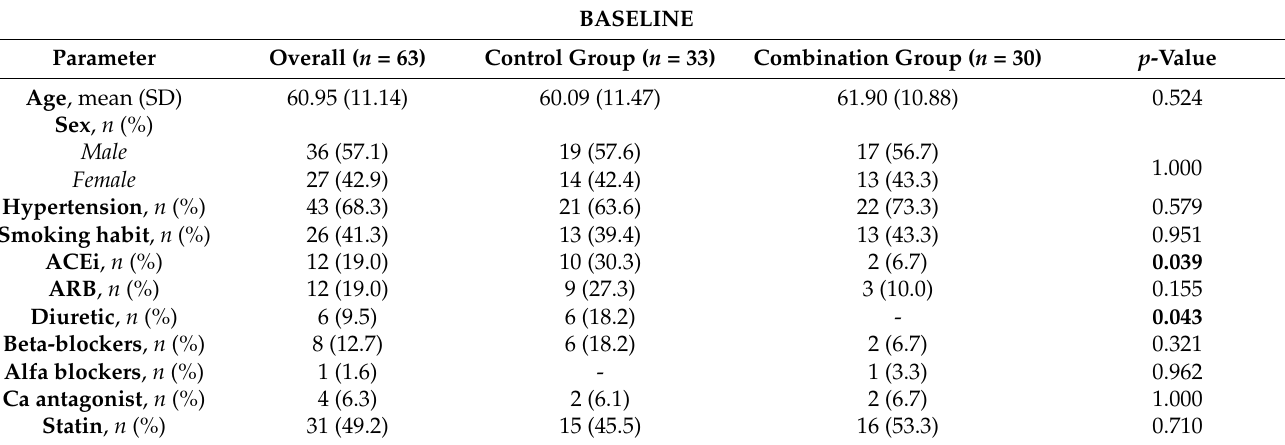
Table 1. Baseline clinical characteristics of the study sample.